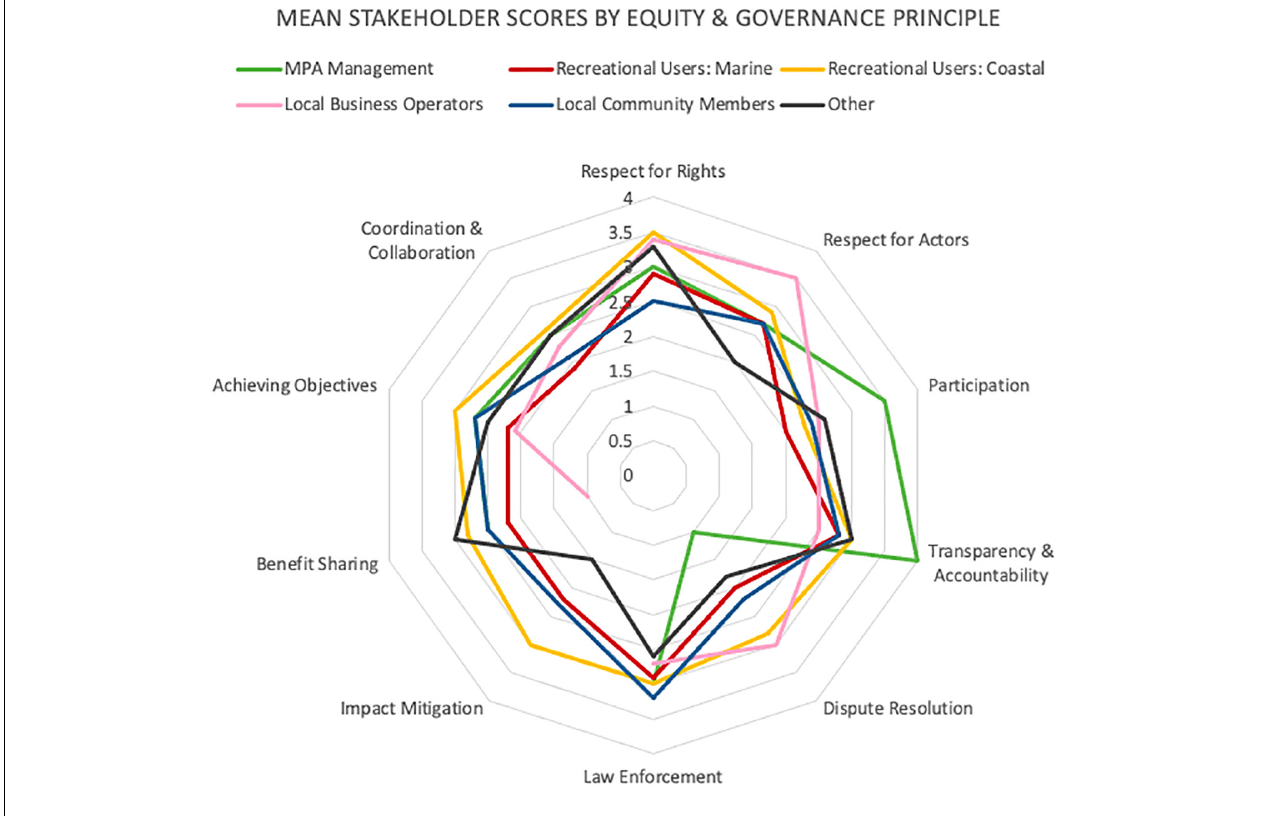
FIGURE 2 | Mean stakeholder scores by equity and governance principle for Strangford Lough.